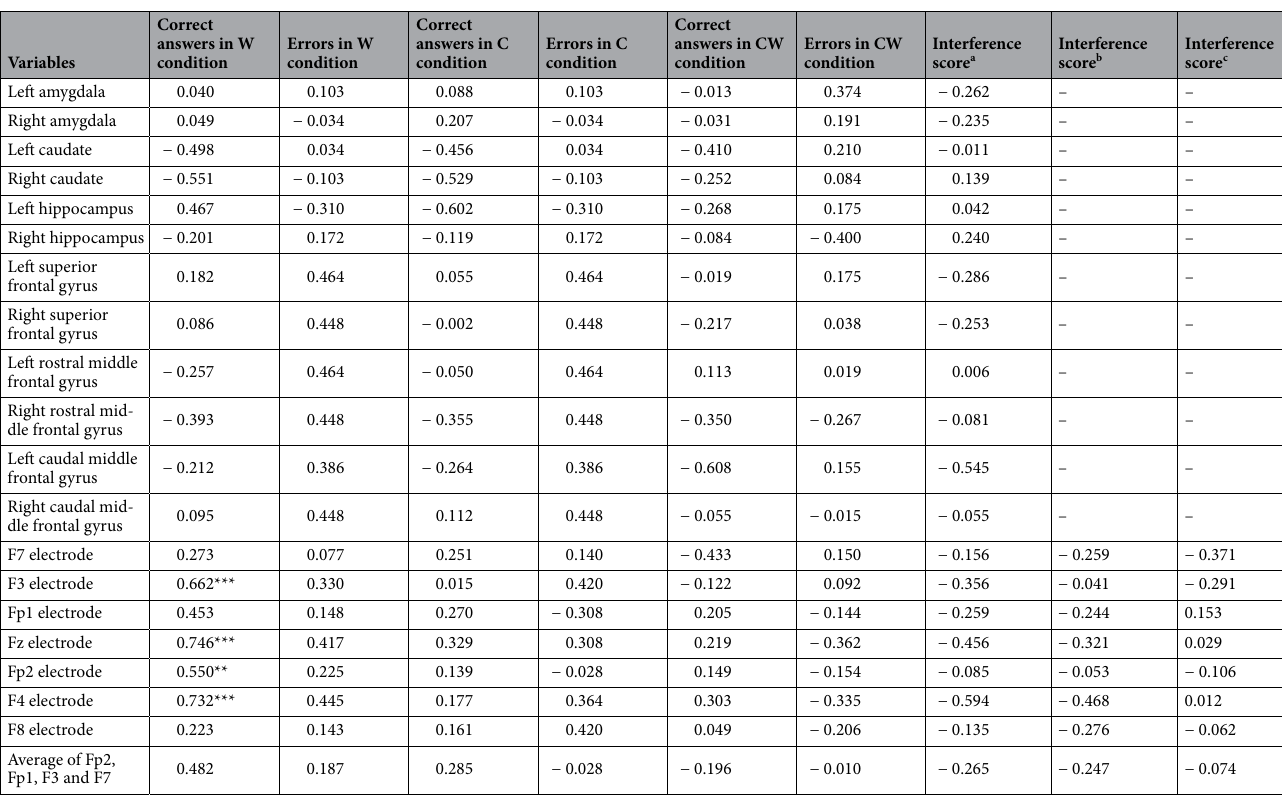
Table 4. Correlations between SCWT performance and MRI structures and frontal EEG theta power spectrum in physically active women with fibromyalgia. W names of colors printed in black, C name